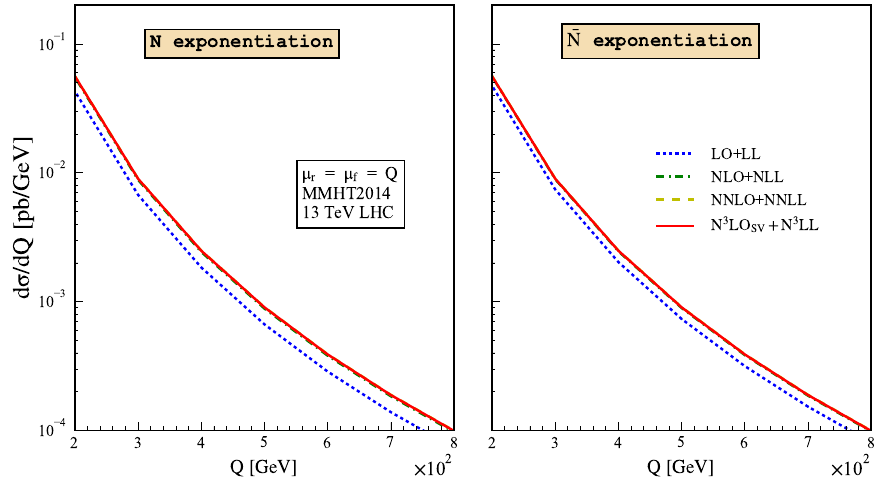
Figure 3 . The comparison between Standard N and N resummation approaches for di-lepton invariant mass distribution is presented up to N 3 LL accuracy for 13 TeV LHC.